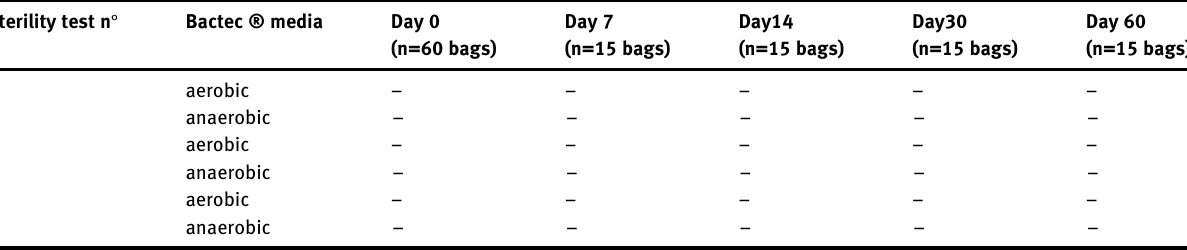
Table  : Results of sterility tests of bags batch produced at Day  , Day  , Day  , Day  and Day  using rapid microbiological method (Bactec®).